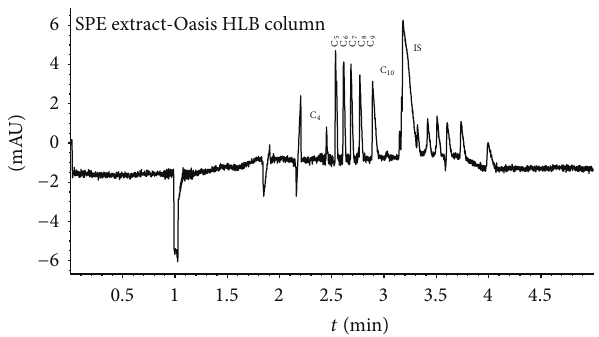
Figure 1: Electropherogram of standard after SPE. The standard mixture contained C 4 –C 10 , TCA, and nonidentified long-chain dicarboxylic acids (C 12 –C 18 ). The analyses were performed with two replicates and six repetitions. Experimental conditions: 4mM PDA + 0.5 mM MTAH, pH 11.0; indirect detection at 310/266 nm; sample injection for 6 sec at 50mbar; separation voltage − 24 kV; analysis time 5 min. DCAs marked in the figure as C 4 –C 10 . IS is the internal standard. After IS migrating peaks are C 14 –C 18 DCAs. They were not included in the main study. Other experimental details in